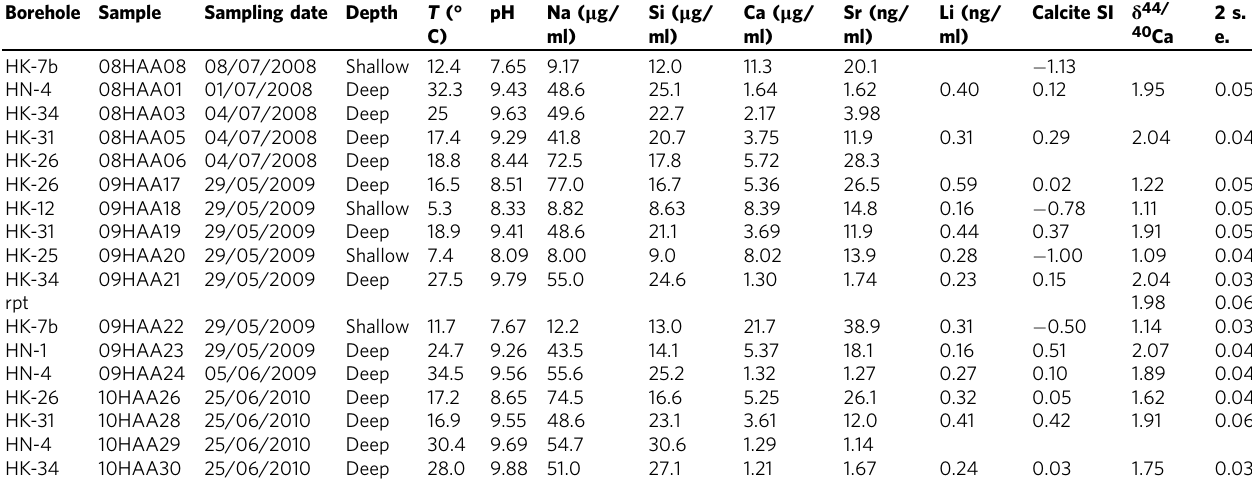
Table 1 Pre-injection conditions, elemental concentrations (from Alfredsson et al. 7 ) and Ca isotope ratios Borehole